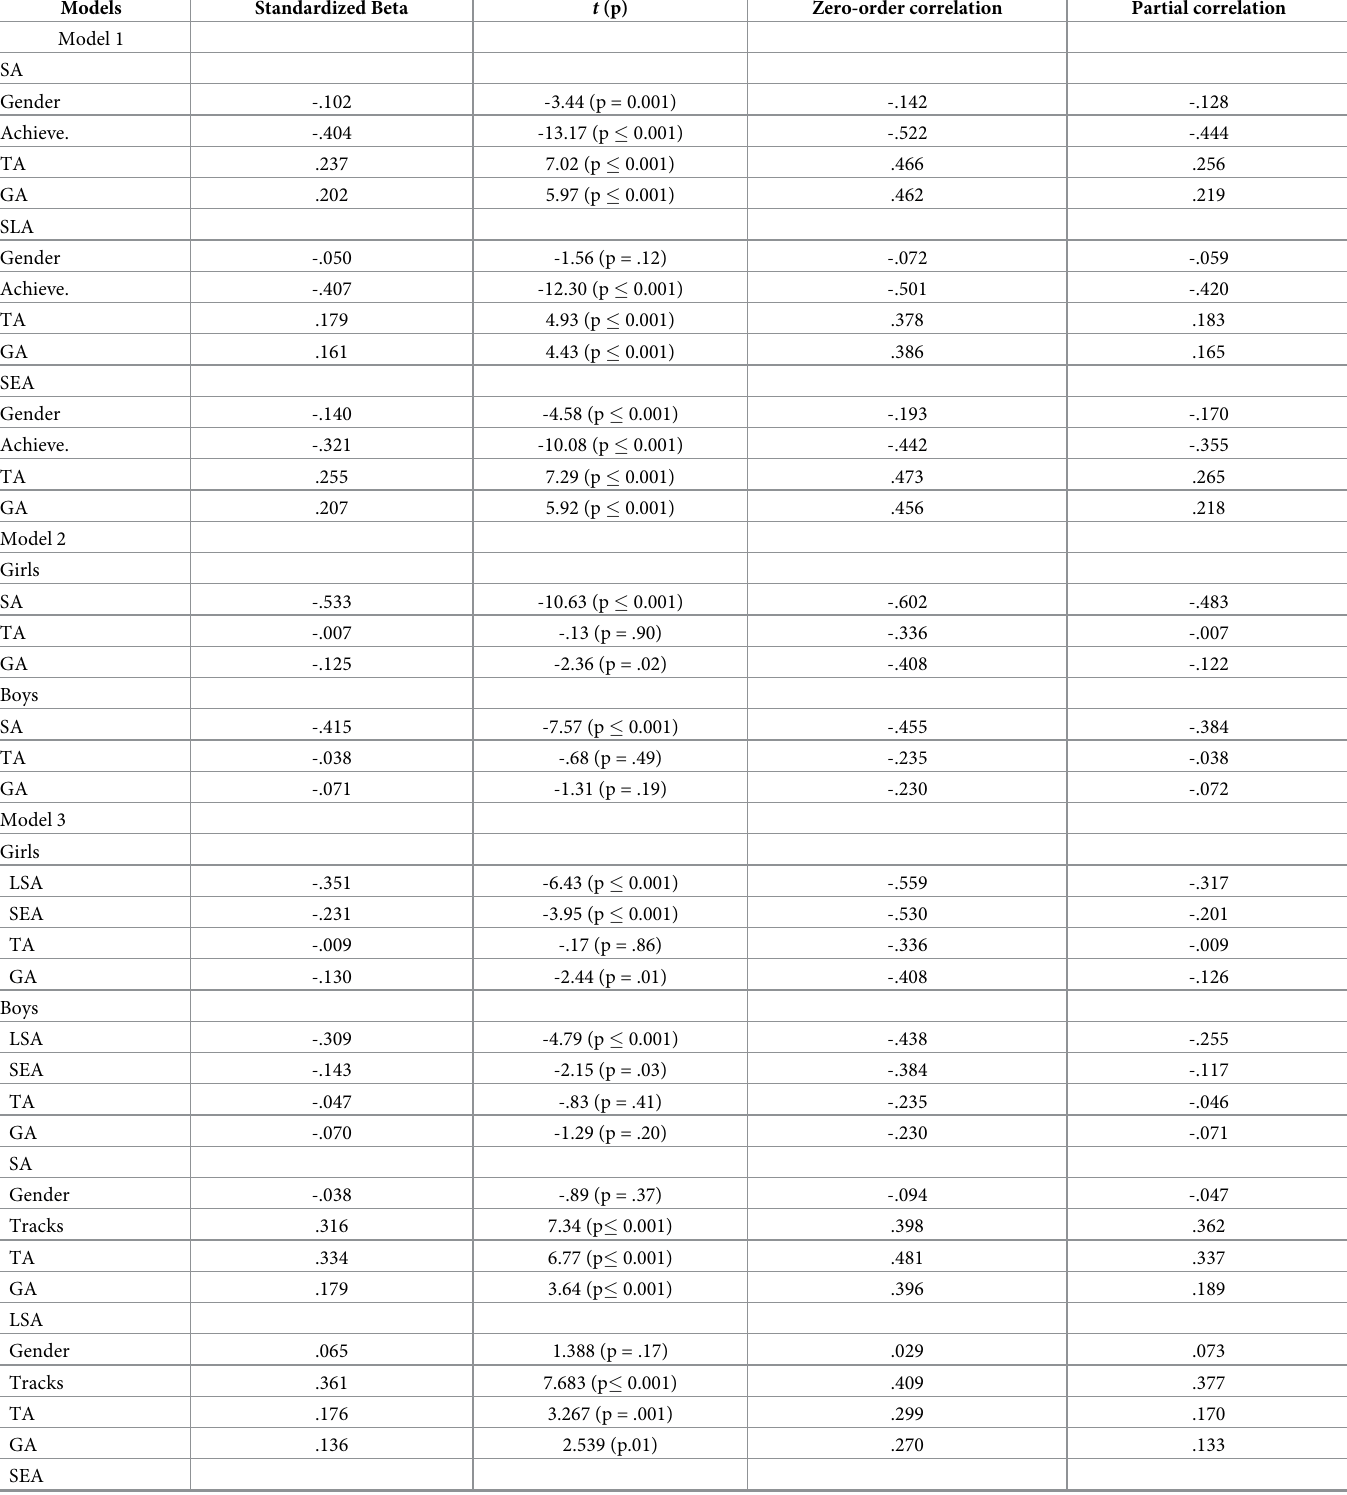
Table 4. The coefficients of the three regression models in Study 1. The coefficient of the multi regression model in Study